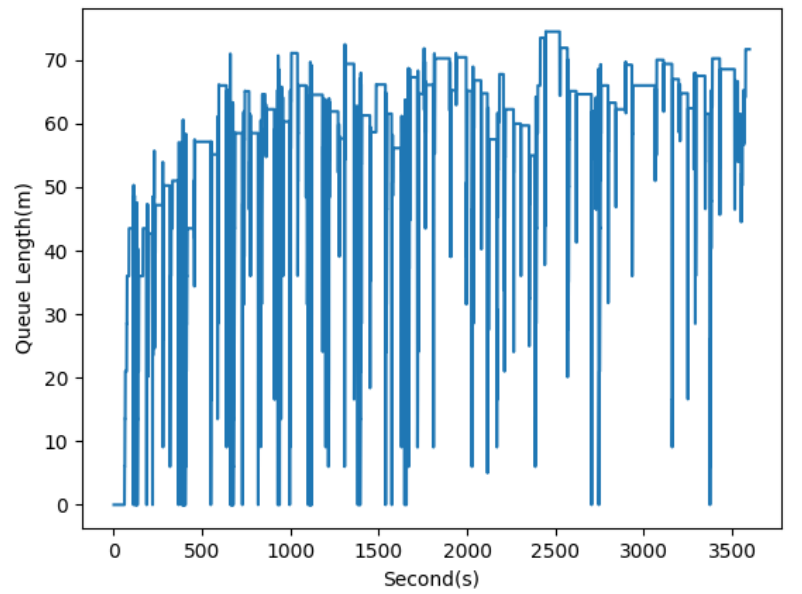
Figure 10. Queue length estimation for edge 1i of INT1 (AVG: 57.59 m, STD: 16.36